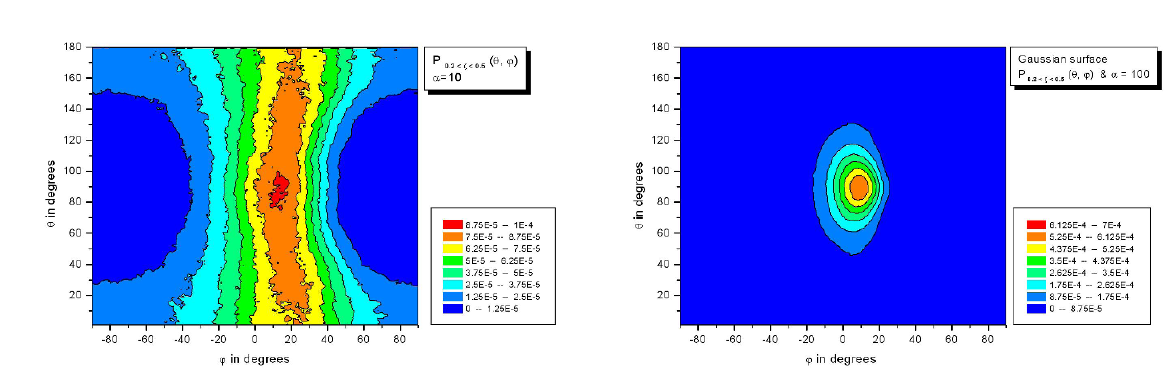
Figure 3. Simulation results for the normalized PDFs, P ϕ ), at Peclet number α = 10, in the depletion layer near an ideally flat solid surface boundary.